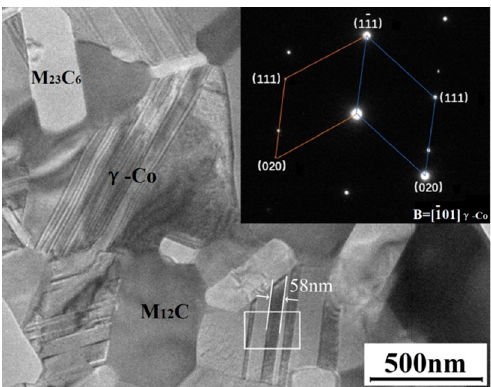
Figure 6. TEM bright field image of the sintered cobalt-based alloy showing a large number of nano-twins in the γ -Co matrix. Inlet is the SAED pattern for the marked area.